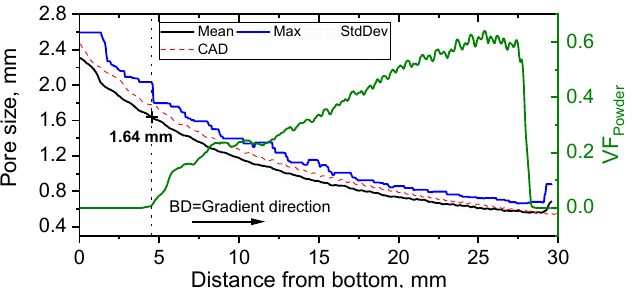
Figure 13. Pores size and volume fraction of entrapped powder (VF powder ) as a function of FGPS height. FGPS